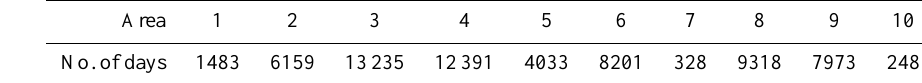
Table 3. Number of days with a 100% snow cover fraction (SCF) in each area in the period of 2001–2010.